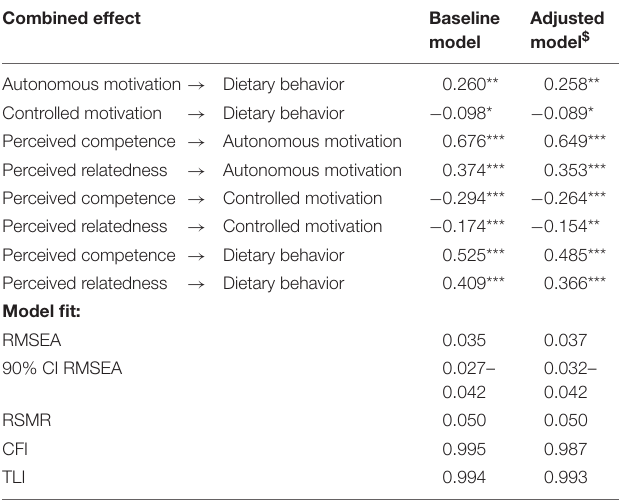
TABLE 2 | Combined effects (direct and indirect effects together) between motivational constructs and dietary